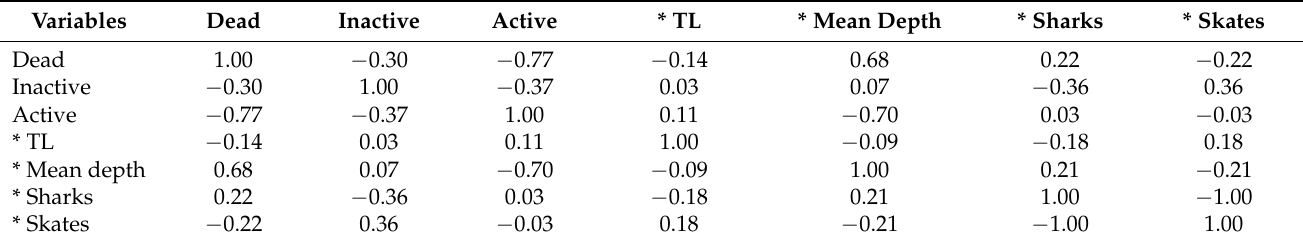
Table 5. Correlation matrix of active and supplementary (asterisked) variables used in the principal component analysis aimed at detecting factors determining differences in the at-vessel vitality rate between nine species of demersal elasmobranchs sampled during a fishery-independent trawl survey in the Asinara Gulf during June–October 2022. Active and supplementary variables are rates of vitality after trawl catch (active, inactive, and dead) and catch mean depth, fish size (TL: total length), and two taxonomical groups (skates and sharks),